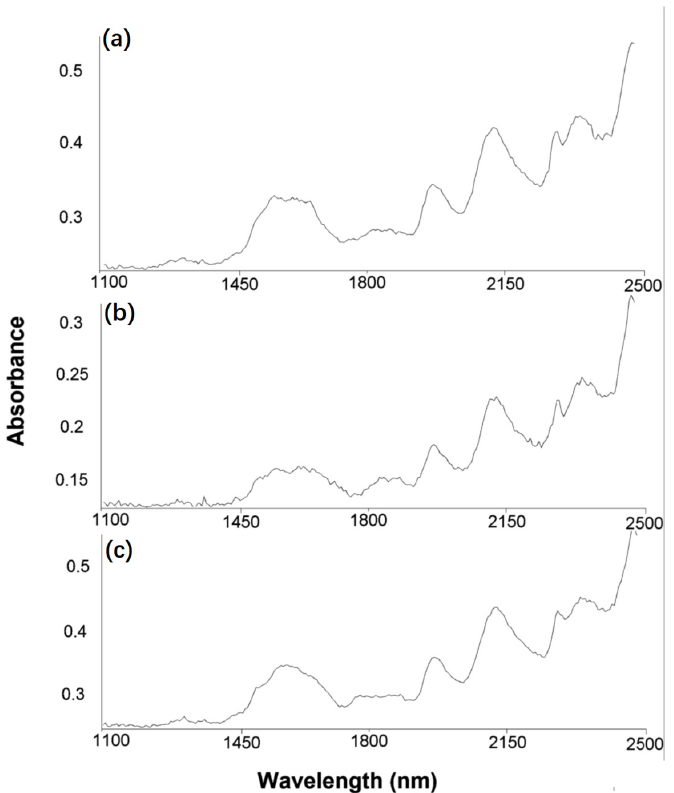
Figure 16. NIR-CI reflectance spectra of RB_204: ( a ) non-dyed cotton fabric; ( b ) dyed cotton fabric, and ( c ) dyed and UV irradiated cotton fabric for 100